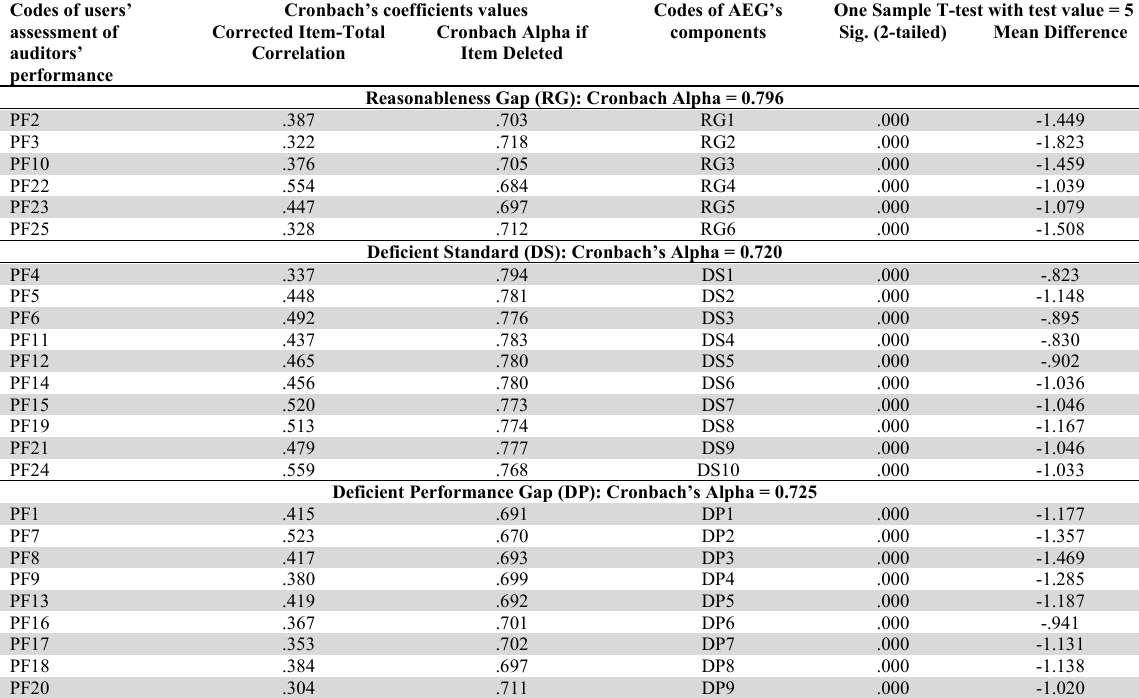
Codes of users’ assessment of auditors’